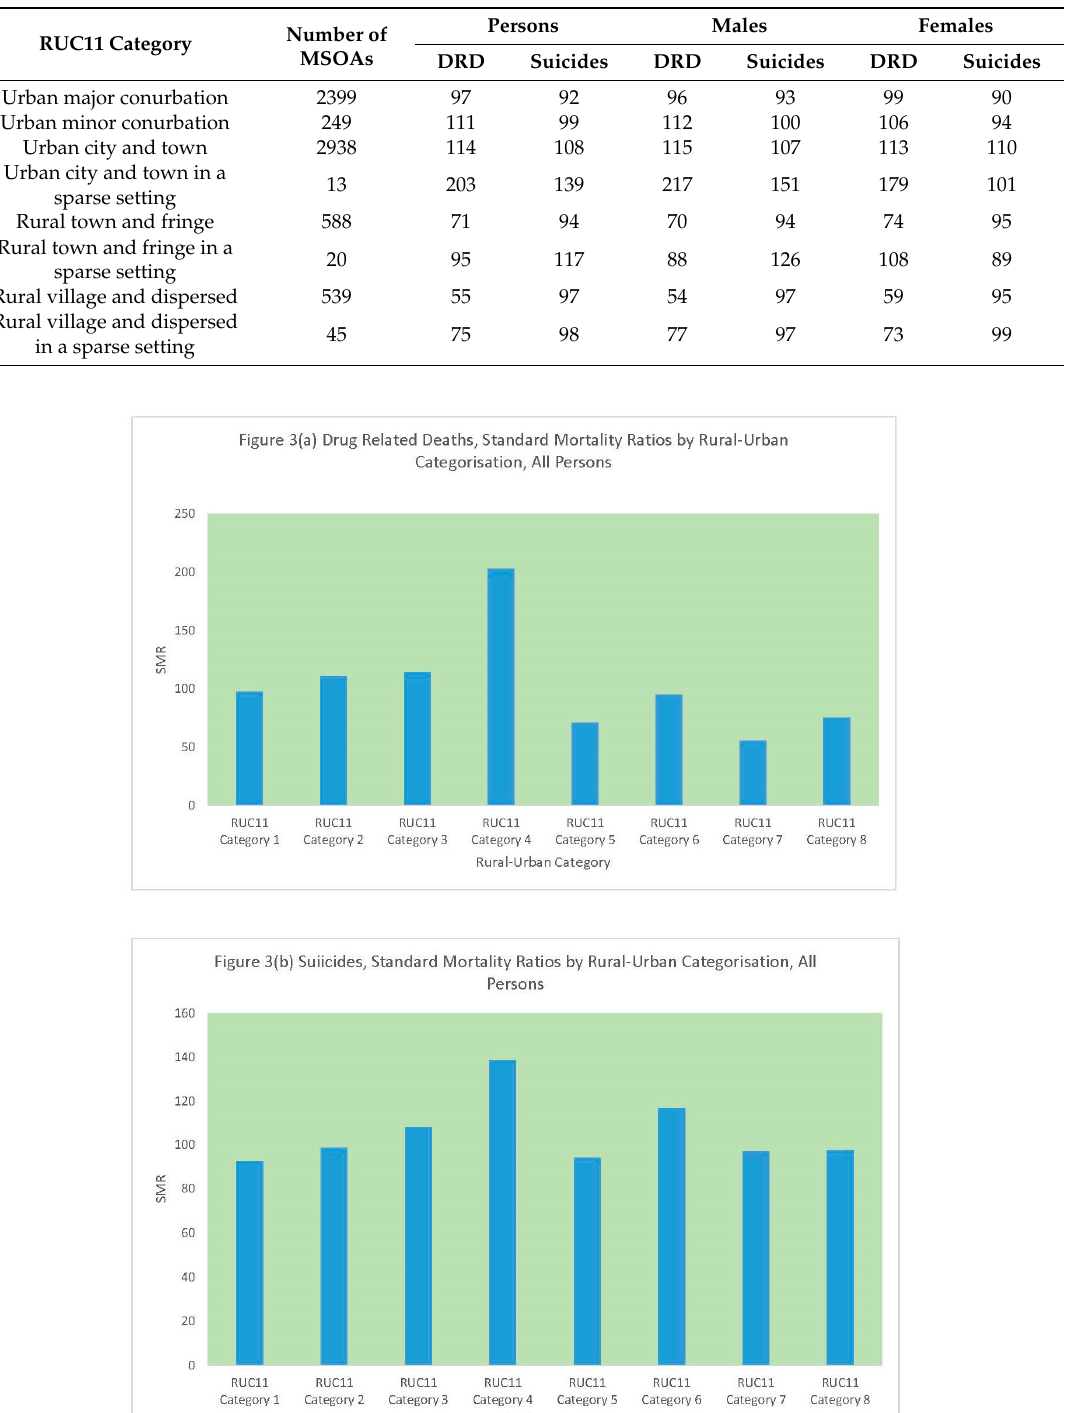
Table 3. Drug-related deaths (DRD) and suicides, standard mortality ratios by rural–urban categorization (England Standard Mortality Ratio (SMR) = 100).